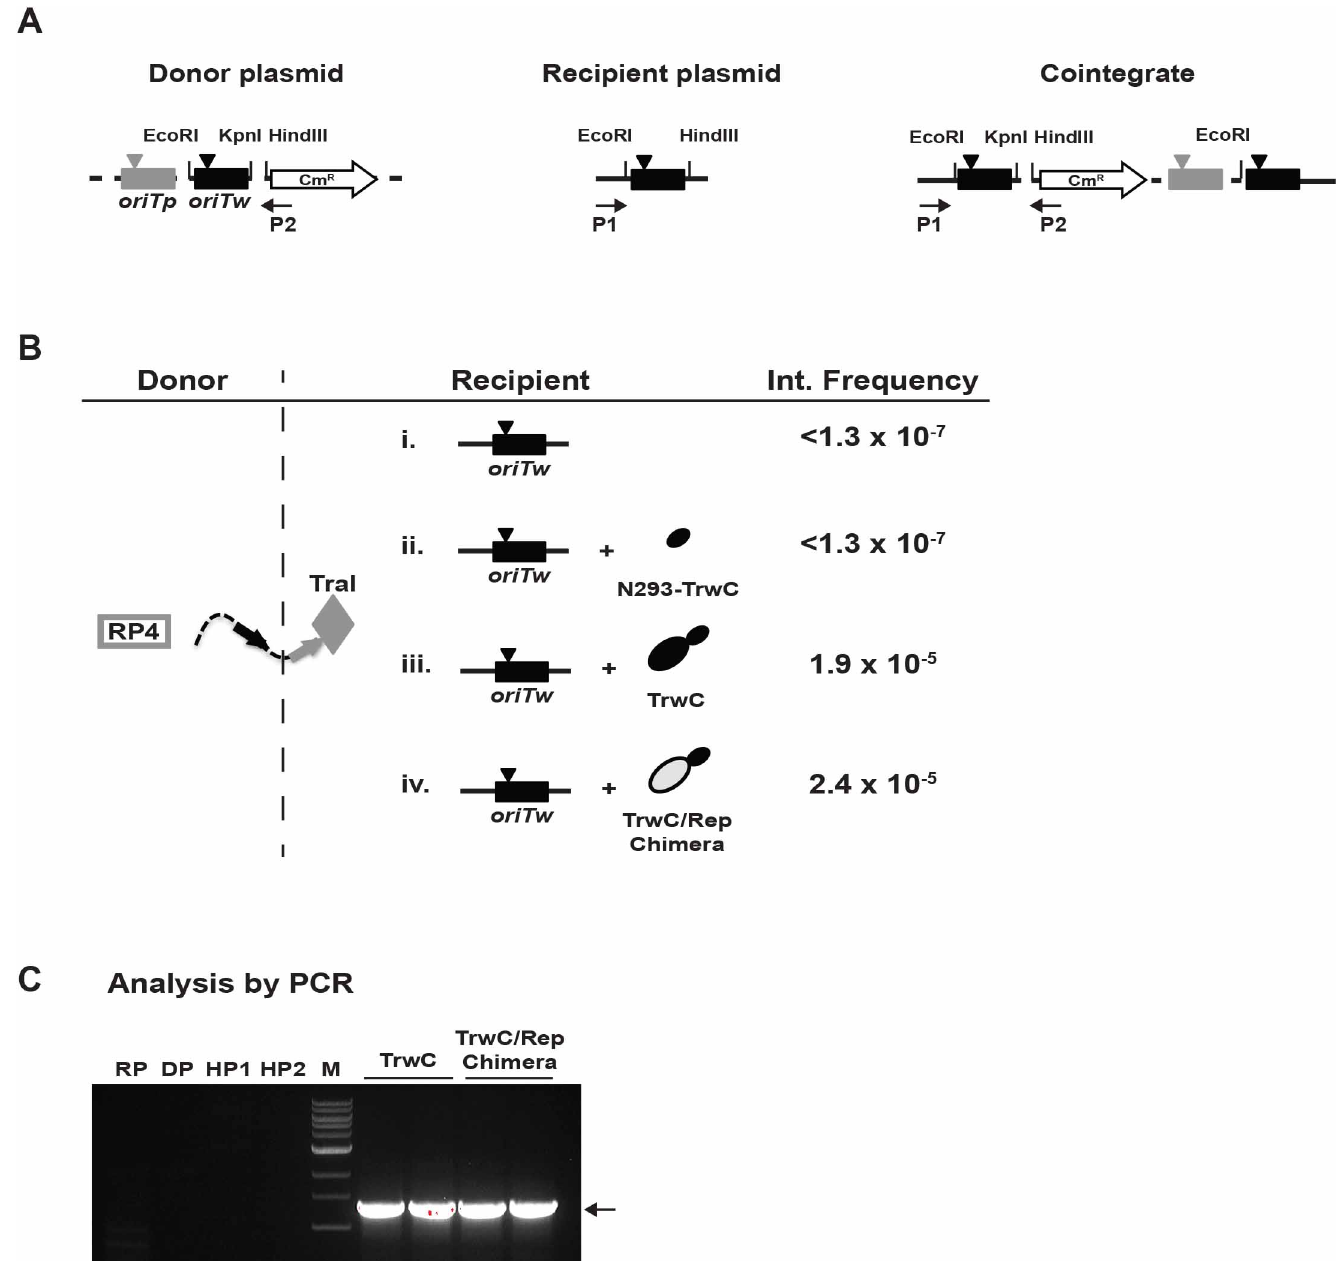
Fig 7. Site-specific integration assay. (A) Scheme of the plasmids used in the assay and the cointegrate molecule obtained. The donor suicide plasmid pCMS11 (pR6K:: oriTp oriTw ) is represented with a dotted line (left panel). oriTp and oriTw , the origins of transfer recognized by the relaxases of plasmids RP4 and R388 respectively, are shown as boxes in grey and black, respectively. nic sites are indicated with triangles in the respective colour code. The chloramphenicol resistance gene is represented as a white arrow (CmR). Recipient plasmid (pLA32) containing oriTw is shown as a black line (center panel). The last plasmid is the result of the integration reaction and is referred to as the cointegrate molecule (right panel). Relevant restriction sites are indicated in each plasmid. P1 and P2 are the oligonucleotides used to amplify the DNA of the integrants. (B) Representation of the integration assay in which the integrase is expressed in the recipient bacteria. The suicide plasmid is mobilized by the TraI relaxase (grey diamond) from the RP4 conjugative system (represented by a square) in a S17.1 λ pir donor strain to a DH5 α recipient harbouring the oriTw -containing plasmid. Four different assays are represented: (i) no expression of integrases in the recipient bacteria (negative control); (ii-iv) recipient bacteria contain a plasmid coding for the relaxase domain of TrwC (N293-TrwC), full-length TrwC, or the TrwC/Rep chimera, respectively. TrwC protein is represented as black ellipses, and the Rep domain, in light gray. Integration frequencies obtained are also shown in the figure. Data are the mean of five independent experiments. Frequency is given as integrants/donors. (C) PCR analysis using primers P1 and P2. Agarose gel showing PCR amplicons (1.2 kb) obtained as a result of the integration reaction mediated by TrwC or TrwC/Rep chimera. RP, recipient plasmid; DP, donor plasmid; HP1, helper plasmid coding for TrwC protein; HP2, helper plasmid for TrwC/Rep chimera expression; M (1kb ladder): 10-8-6-5-4-3-2-1.5–1